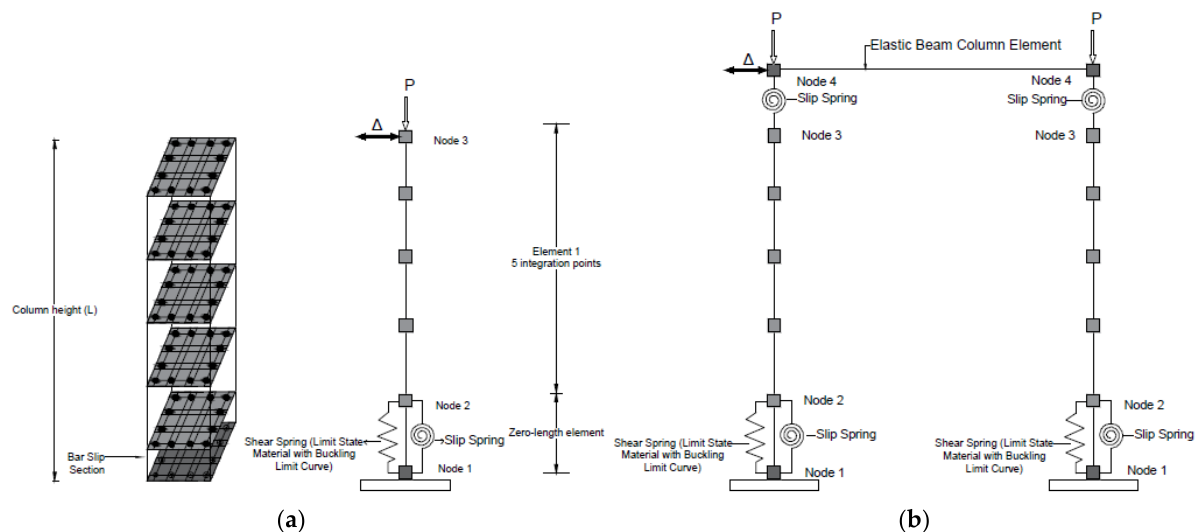
Figure 16. Numerical models for bridge ( a )column; ( b ) frame.